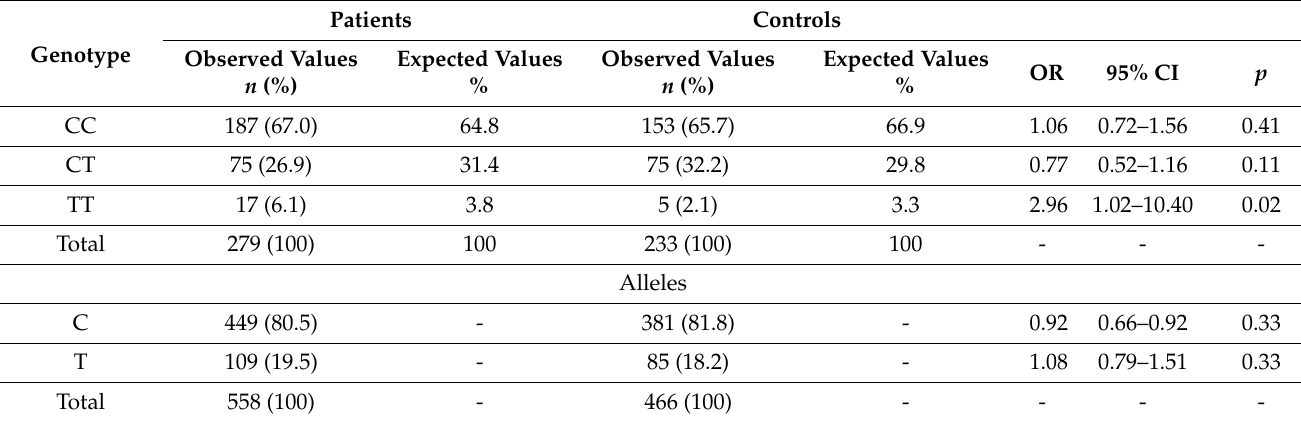
Table 1. Distribution of NQO1 609C > T polymorphism in patients with colorectal cancer and the controls.